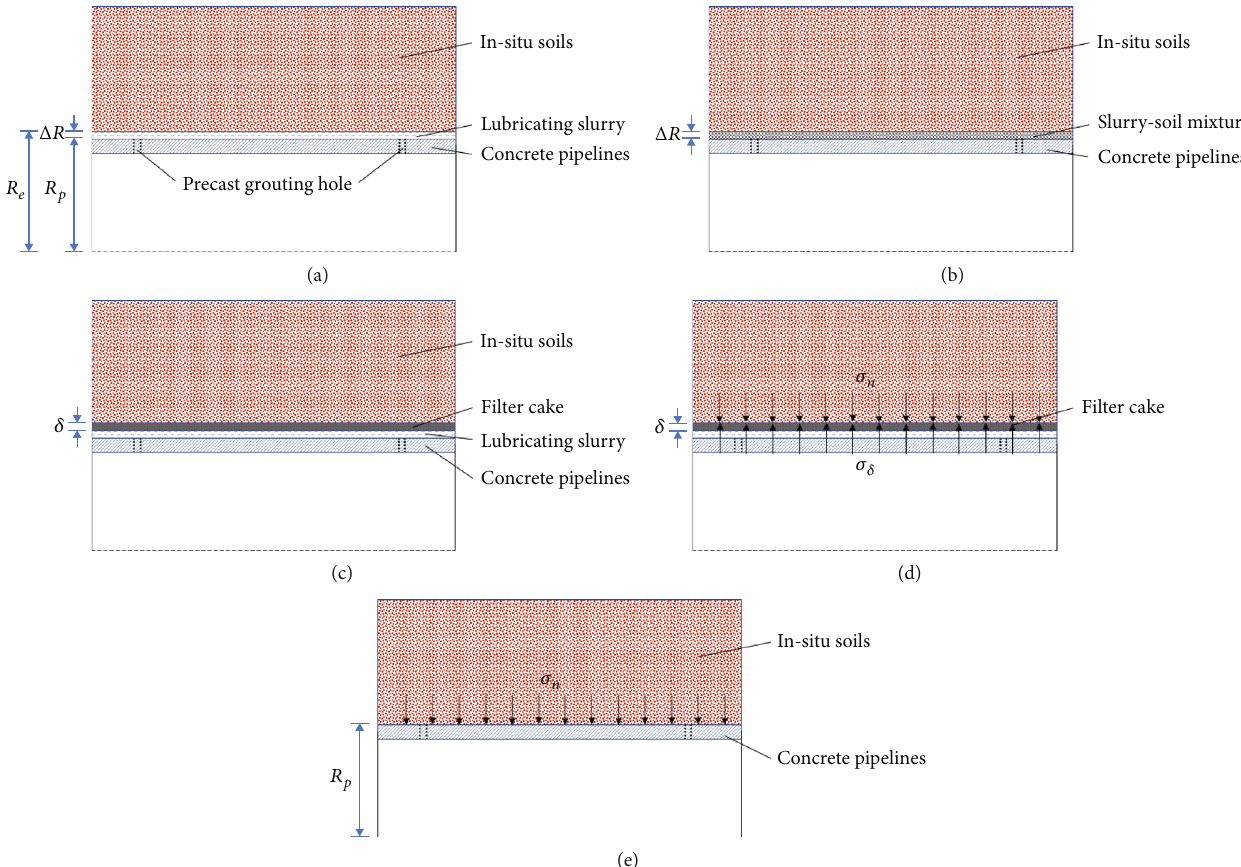
Figure 2: Schematic diagram of the whole process of grouting disturbance. (a) Initial grouting and fi lling overcut area. (b) Slurry seepage and forming slurry-soil mixture. (c) The slurry compresses the soil and forms a fi lter cake. (d) The surrounding soil maintains it stability at excavation hole. (e) The surrounding soil lose it stability at excavation